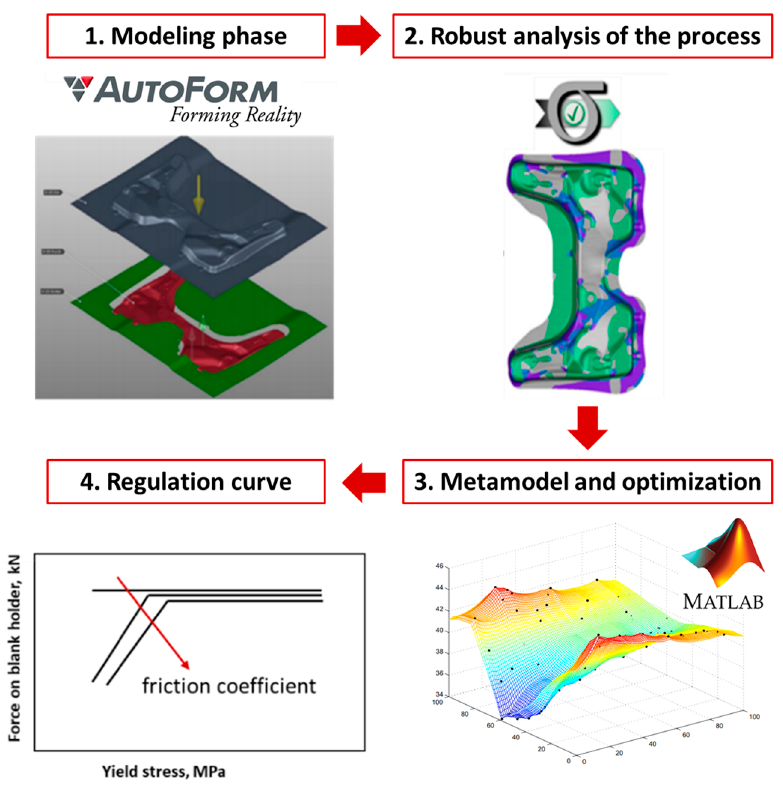
Figure 3. Scheme of adopted methodology.